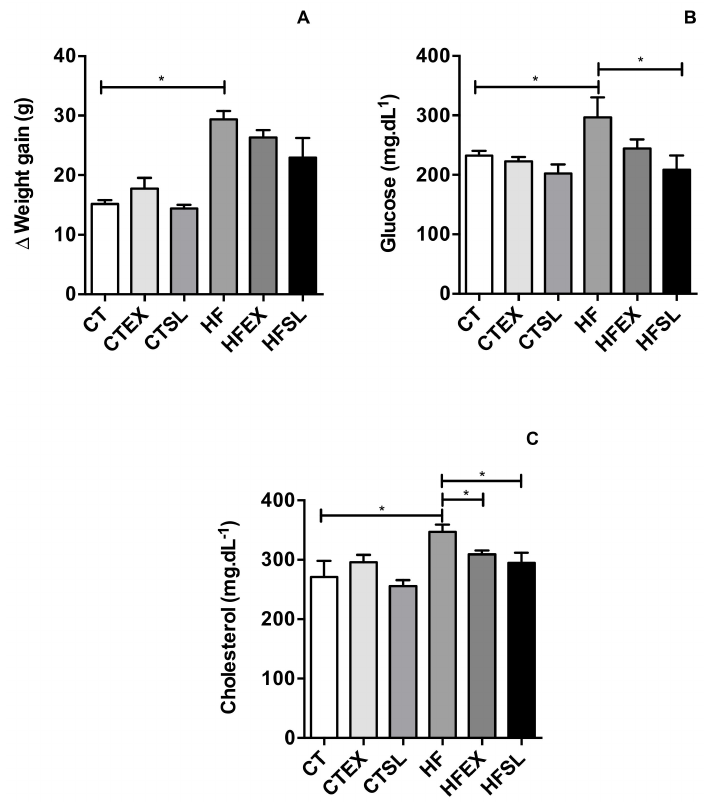
Figure 4. Animals weight gain, obtained by the difference between the final weight (9 weeks) and the initial weight of the animals in each group ( A ). Fasting blood glucose (mg · dL − 1 ) of the animals at the end of the experiment (9 weeks) ( B ) Concentration of total cholesterol (mg · dL − 1 ) in the plasma of the animals at the end of the experiment (9 weeks) ( C ) ( n = 5 animals per group). CT: control